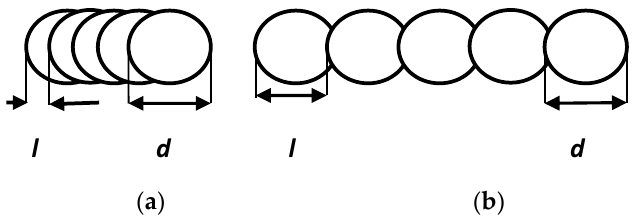
Figure 5. Overlapping of successive pulses generated with a frequency of 80 kHz. ( a ) For v = 400 mm/s; ( b ) For v = 4000 mm/s.